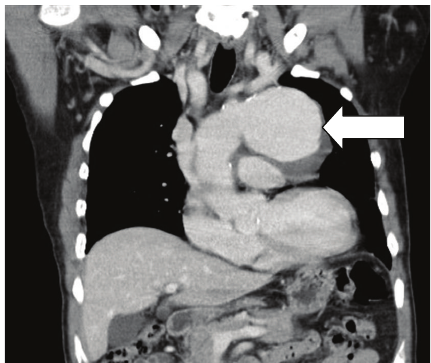
Figure 4: Aortic aneurysm at proximal descending aorta in coronal scanning